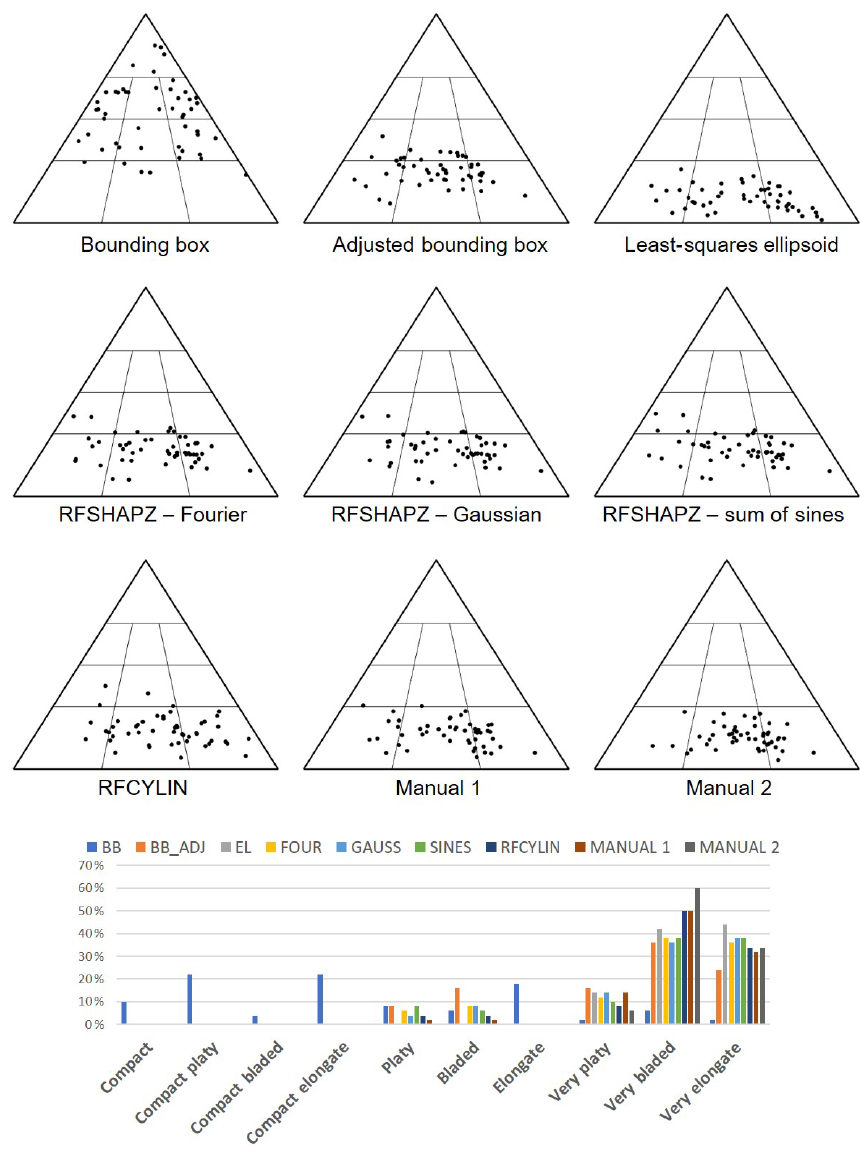
Figure 13. Sneed and Folk ternary diagrams for each of the model fits for the 50 rockfall events that occurred in the White Canyon. The bar chart at the bottom highlights the percentage of classes for each of the fits. BB: bounding box; BB_ADJ: adjusted bounding box; EL: least-squares ellipsoidal fit; FOUR: RFSHAPZ Fourier fit; GAUSS: RFSHPZ Gaussian fit; SINES: RFSHAPZ sum of sines fit; RFCYLIN: RFCYLIN